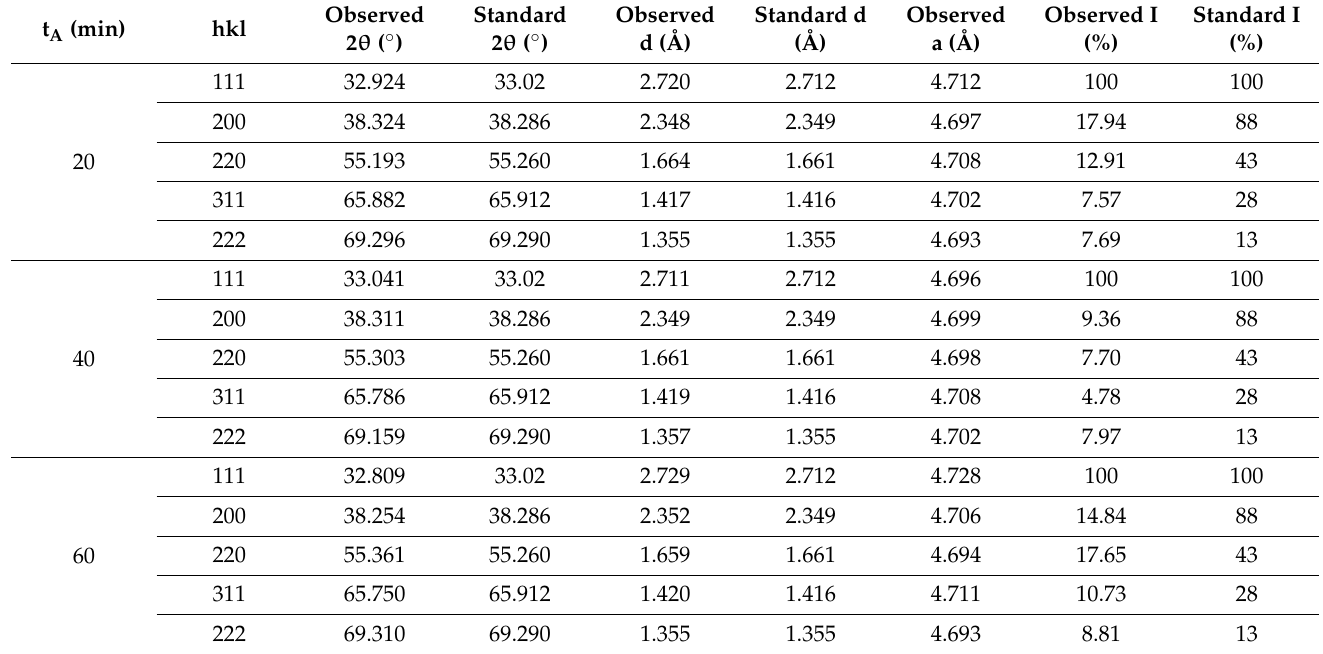
Table 2. The observed and standard values of some XRD parameters for CdO thin films.